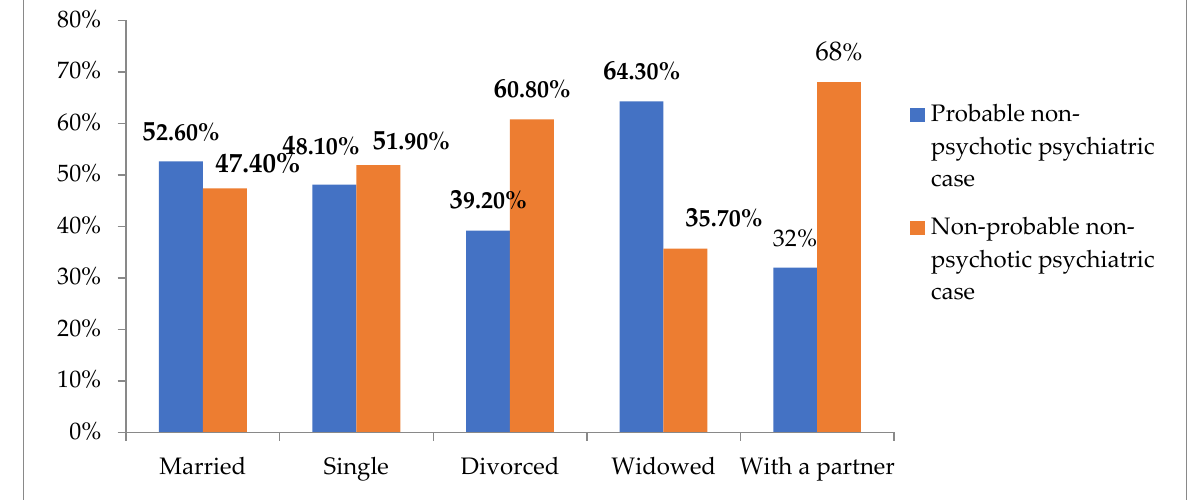
Figure 6. Results in GHQ-12 as a function of marital status.